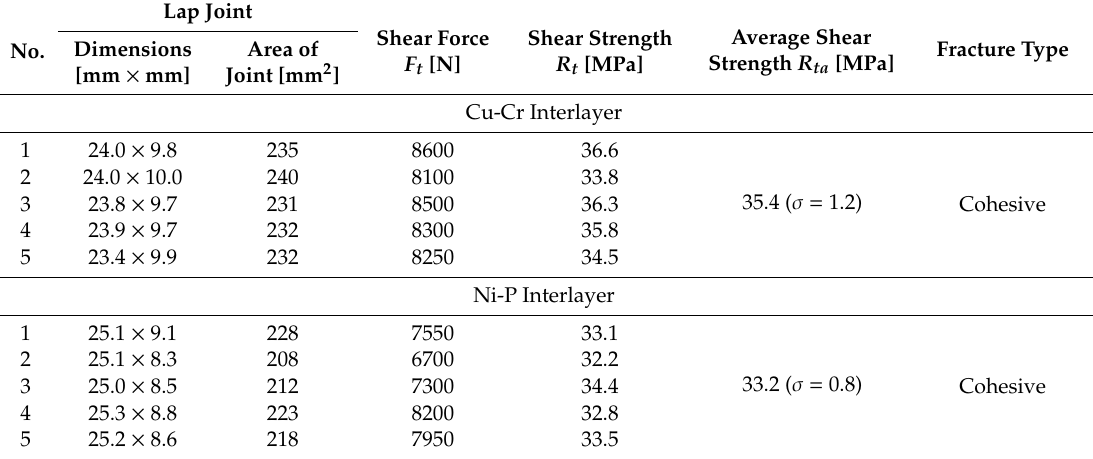
Table 5. Shear strength of soldered joints made via Cu-Cr and Ni-P interlayers.